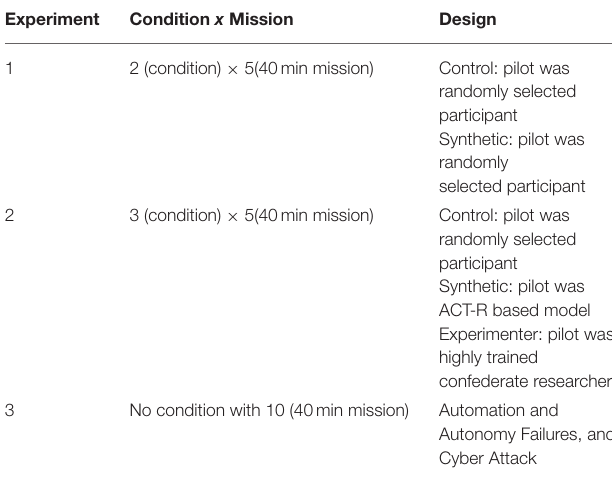
TABLE 2 | Experimental design for three RPAS